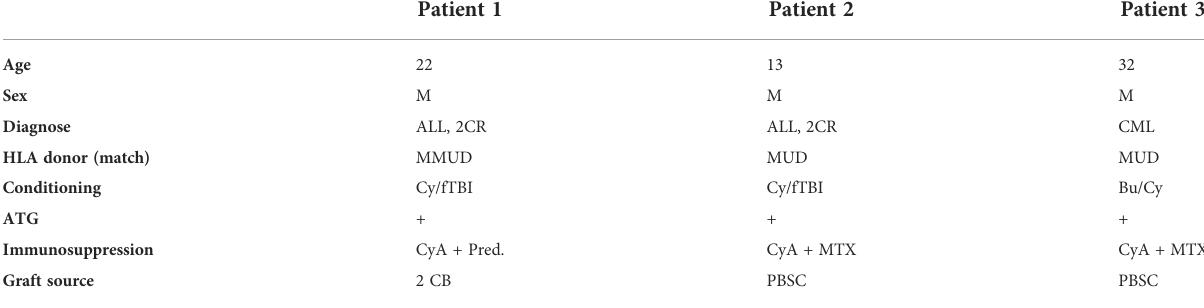
TABLE 1 Characteristics of three patients, diagnosed with